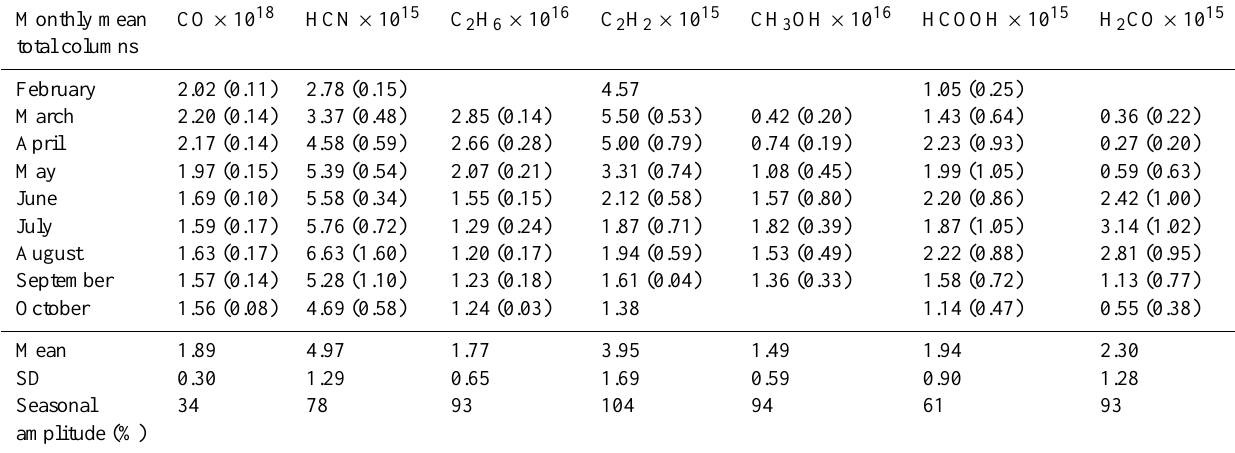
Table 4. Monthly mean total columns (in moleculescm − 2 ) for all trace gases derived in this study from 2007 to 2011. Numbers in parentheses correspond to the one-sigma standard deviation around the monthly mean. The three last rows show the annual means, the one-sigma standard deviation (SD) and the seasonal amplitude in percentage.